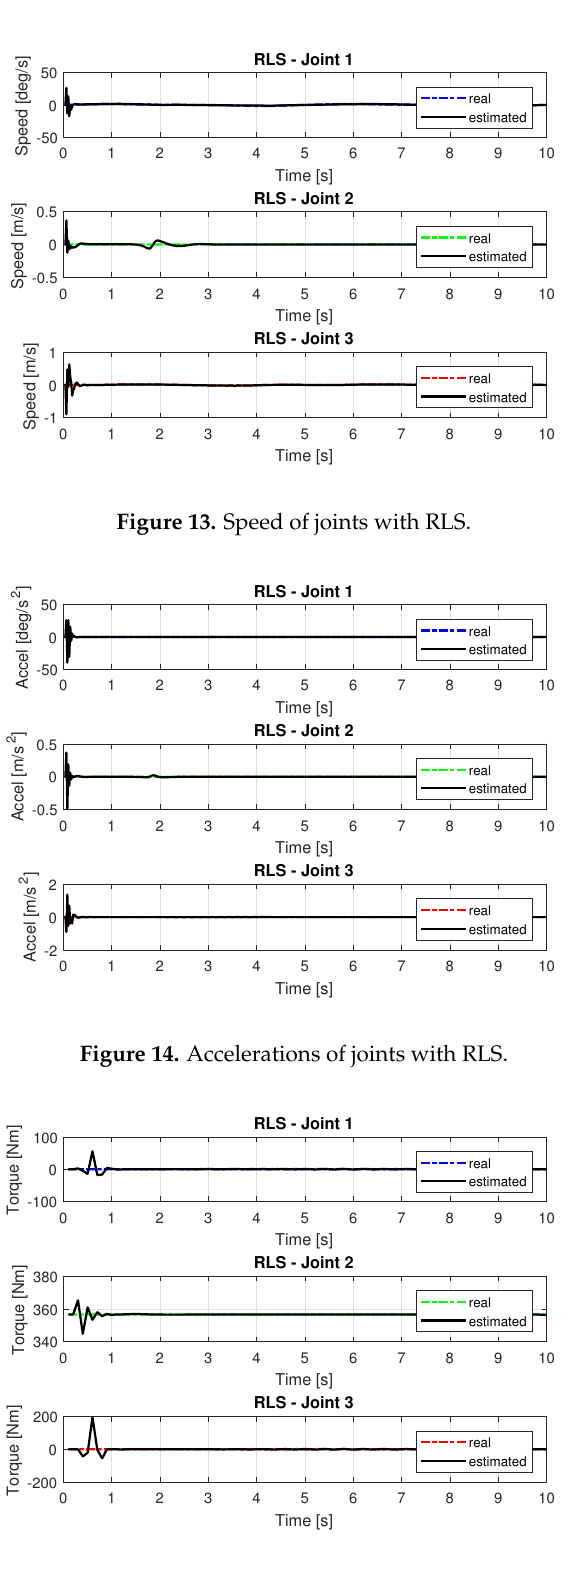
Figure 15. Torque of joints with